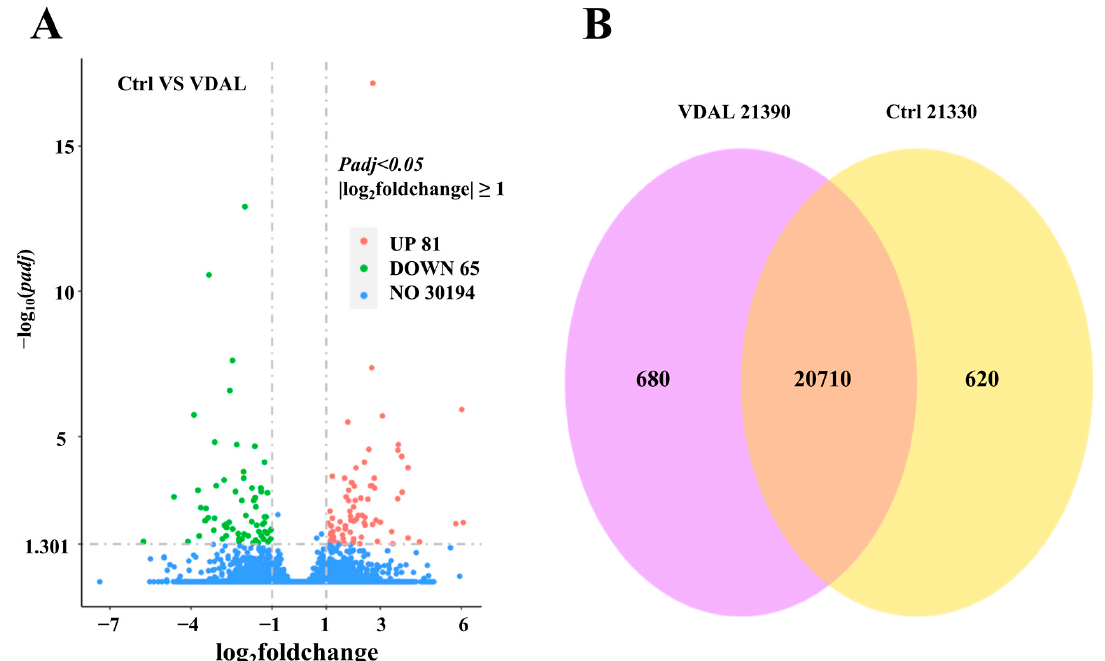
Figure 6. RNA-Seq data analyses. ( A ) Volcano plot of the overall DEGs distribution. The sum of read count values for each gene in the volcano map in different samples is greater than one. Genes with significant differences compared to the two groups were screened by threshold |log 2 Fold Change| ≥ 1 and Padj ≤ 0.05. The X-axis depicts fold change in gene expression and the Y-axis depicts statistical significance. Red dots represent significantly up-regulated DEGs (UP), green dots represent significantly down-regulated DEGs (DOWN), and blue dots represent non-differentially expressed genes (NO). ( B ) The Venn diagram plots statistics for all expressed genes with FPKM > 1 in both VDAL and Ctrl. The pink area shows the genes expressed by VDAL, the yellow area shows the genes expressed by Ctrl, and the overlapping area shows the genes co ‐ expressed by VDAL and Ctrl.